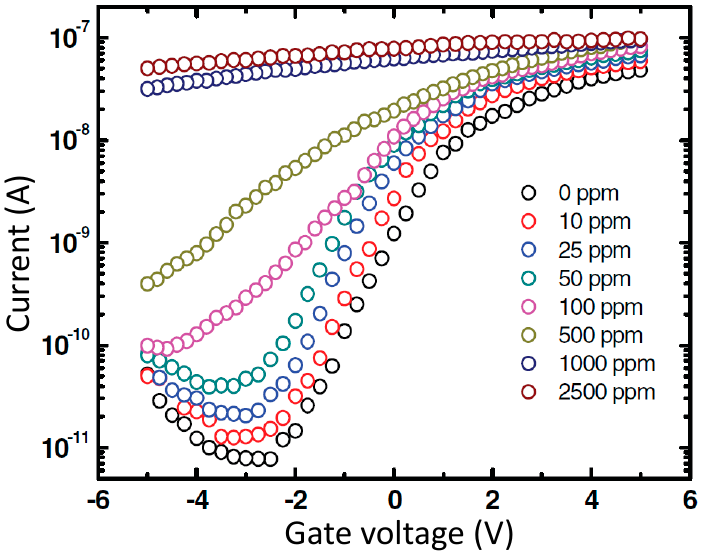
Figure 4. Transfer characteristics of Pd-nanoparticle decorated SnO under different H partial pressures. The bias voltage is 0.5 V. Reprinted from reference [71] 2 with permission from John Wiley and